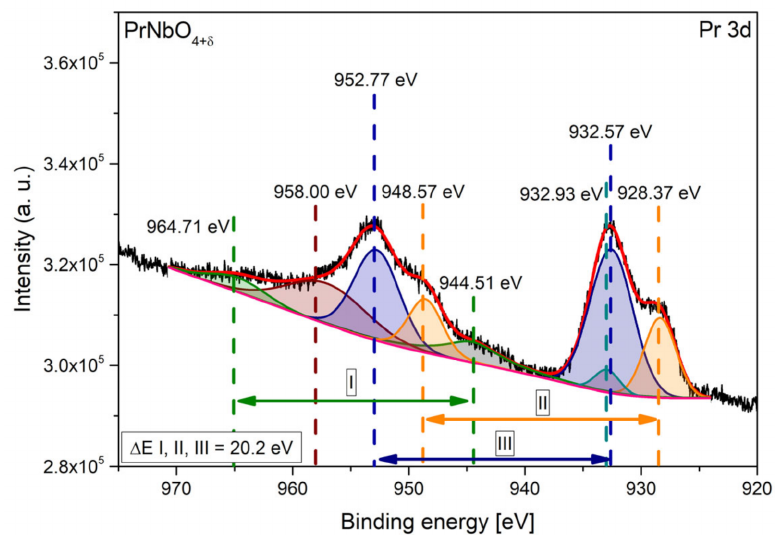
Figure 5. XPS spectrum collected for Pr 3d band.